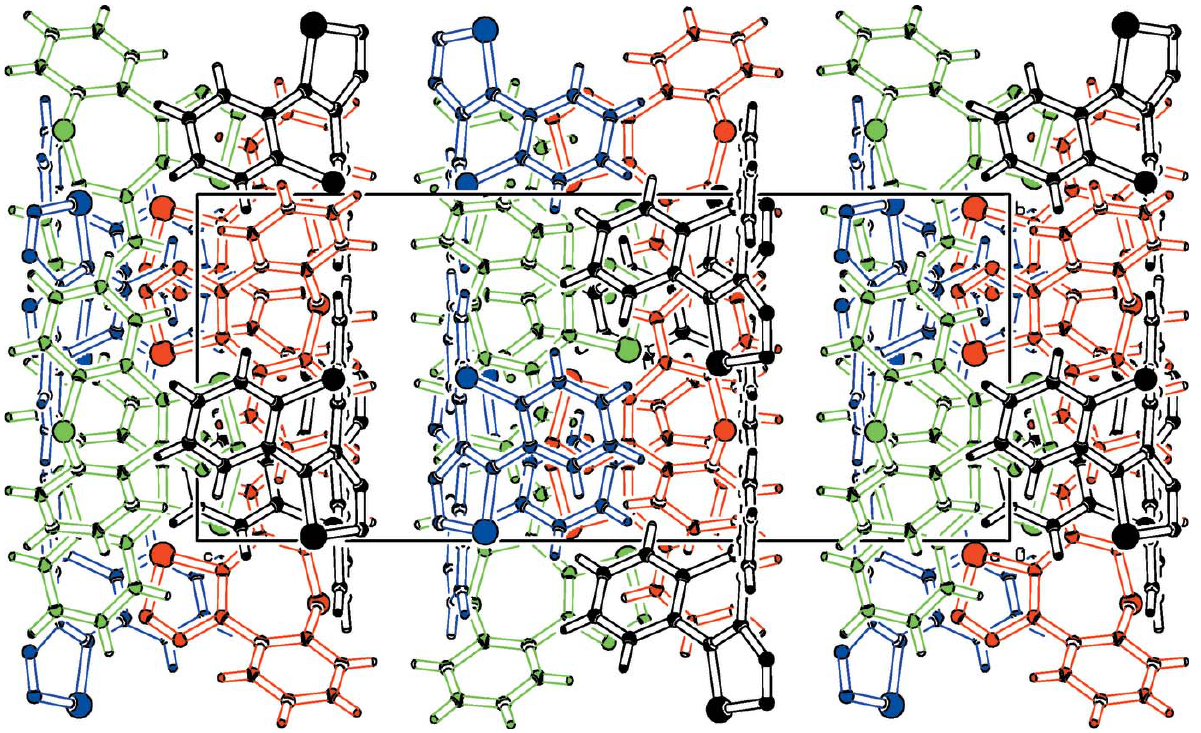
Figure 2 The crystal packing in the title compound in a view along the a axis. The four independent molecules are shown in different colours.